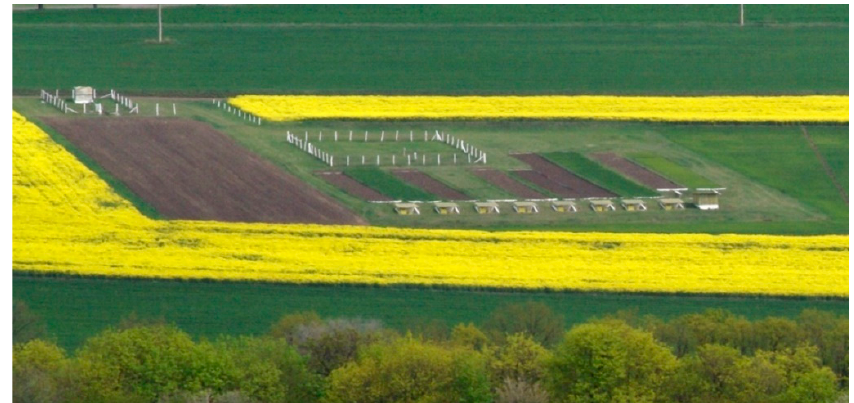
Figure 2. Standard plots for drain control overview. Source: [ 7]